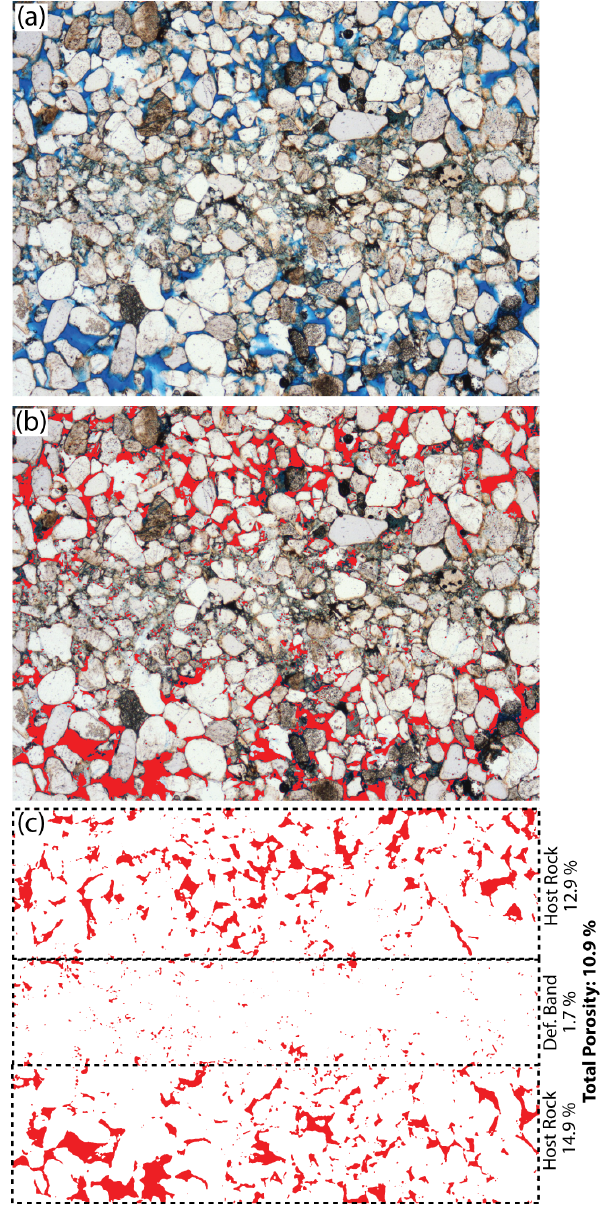
Figure 6. Quantitative determination of porosity percentages using ImageJ. (a) Sections were impregnated with blue-dyed plastic resin in order to highlight porosity. (b) Image analysis using ImageJ to select areas (red) containing blue dye. (c) Percentage areas (porosi- ties) can then be calculated for both whole section and selected areas (e.g. host rock vs deformation band). Note the substantially lower porosity and smaller pore size within the deformation